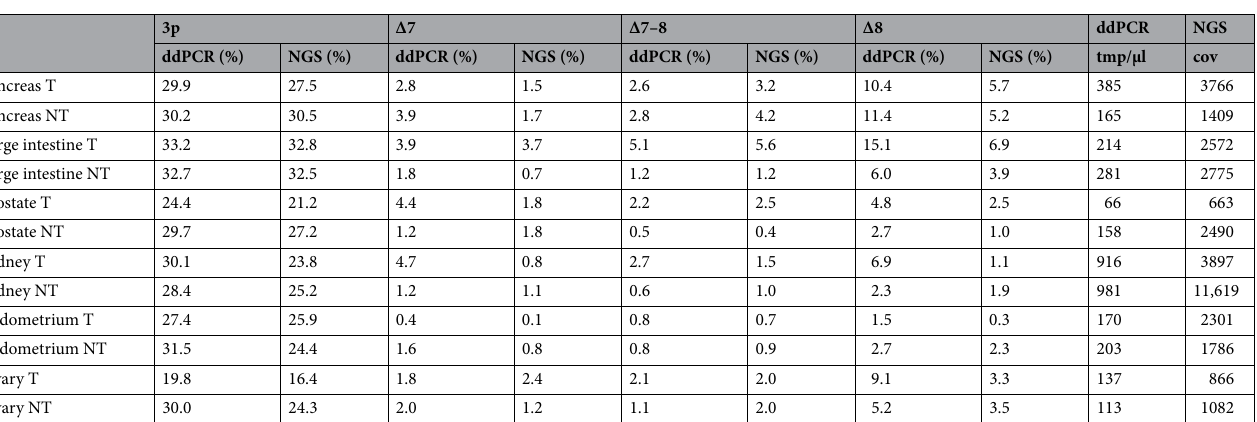
Table 3. The proportion of alternative splicing variants calculated from ddPCR-based and NGS-based data in selected paired tumour and non-tumour tissues (with raw data overview). Numbers represent the percentage of each individual variant related to the overall HNF1B mRNA expression (calculated as the sum of canonical exon 3 and 3p variants in both approaches). Each line represents data from one representative sample; ddPCR tmp/µl represents number of HNF1B templates per 1 µl of cDNA detected by ddPCR; NGS cov. represents peak coverage of HNF1B exon 3. T tumour tissue, NT non-tumour